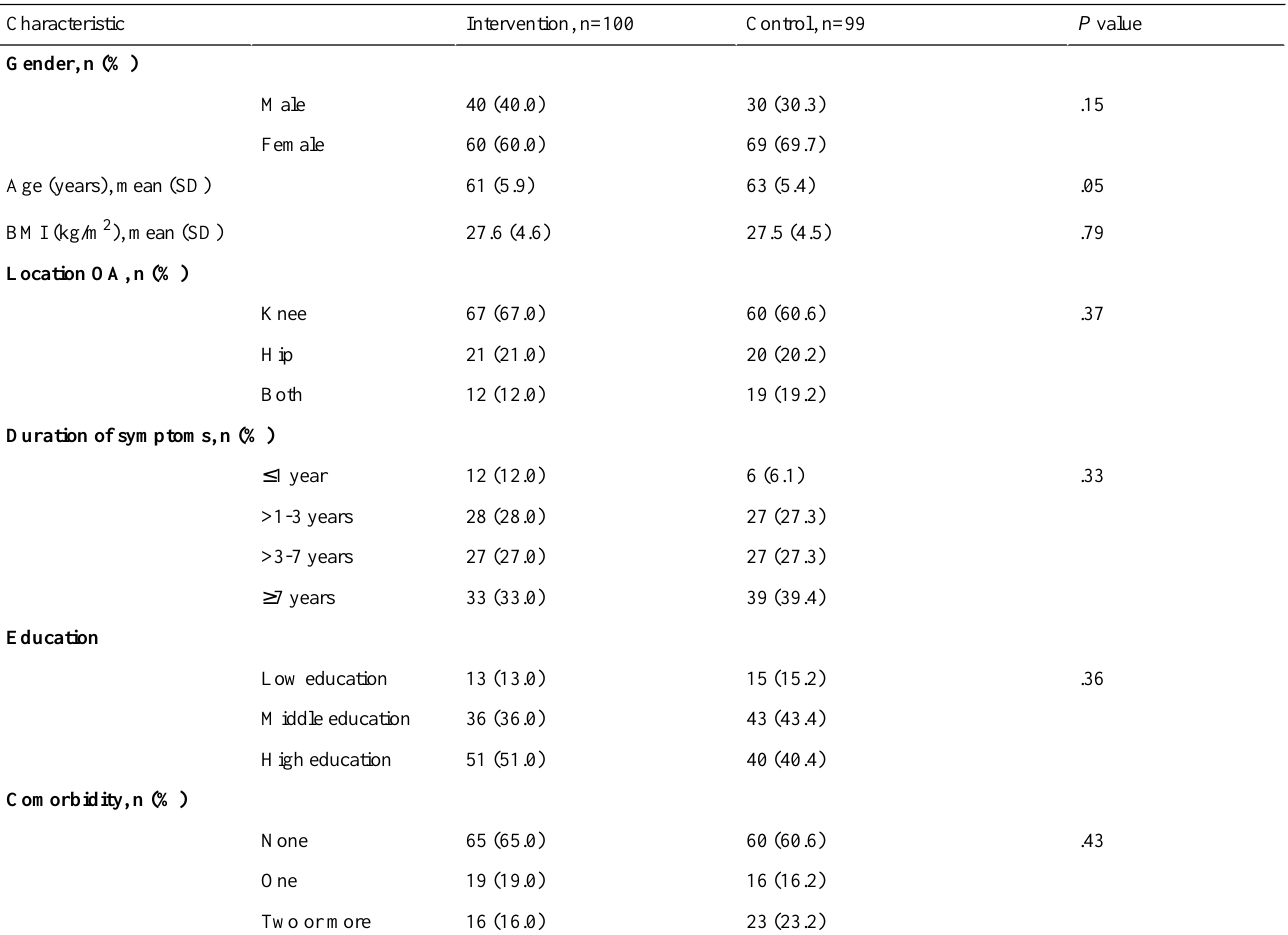
Table 1. Baseline demographic and clinical